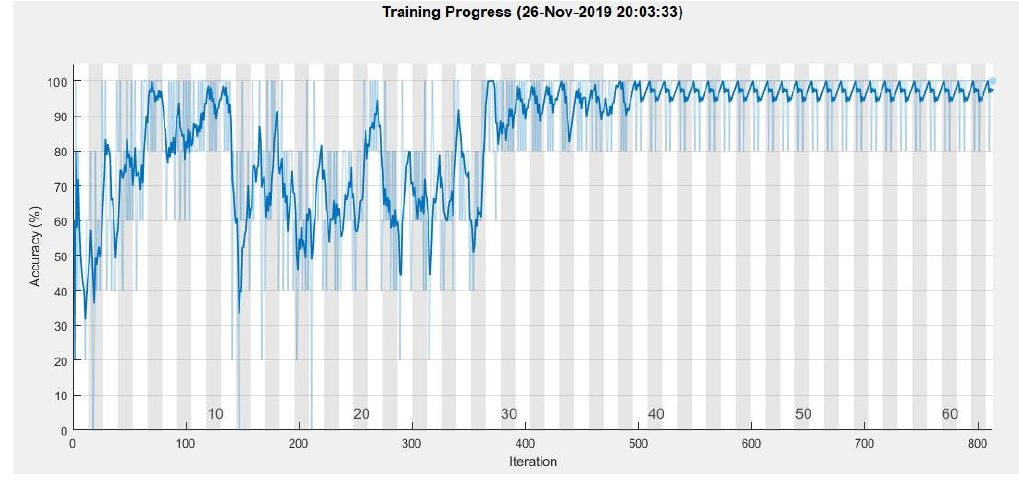
Figure 12. Training process with standardized data.